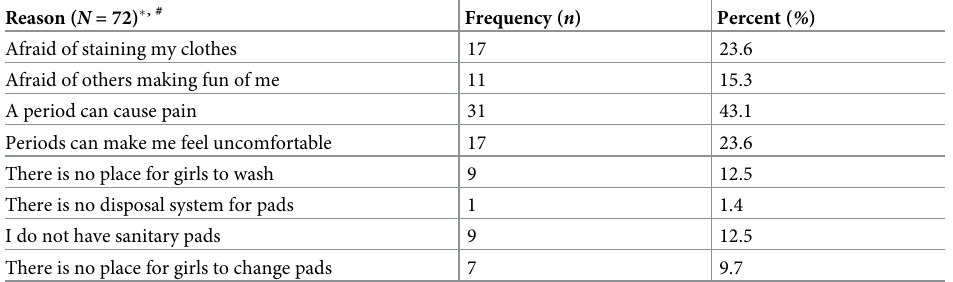
Table 8. Reasons for menstruation-related school absenteeism among high school girls of Dessie City, Amhara Region, northeastern Ethiopia, 27 January to 6 March 2020. Reason ( N = 72) � , #